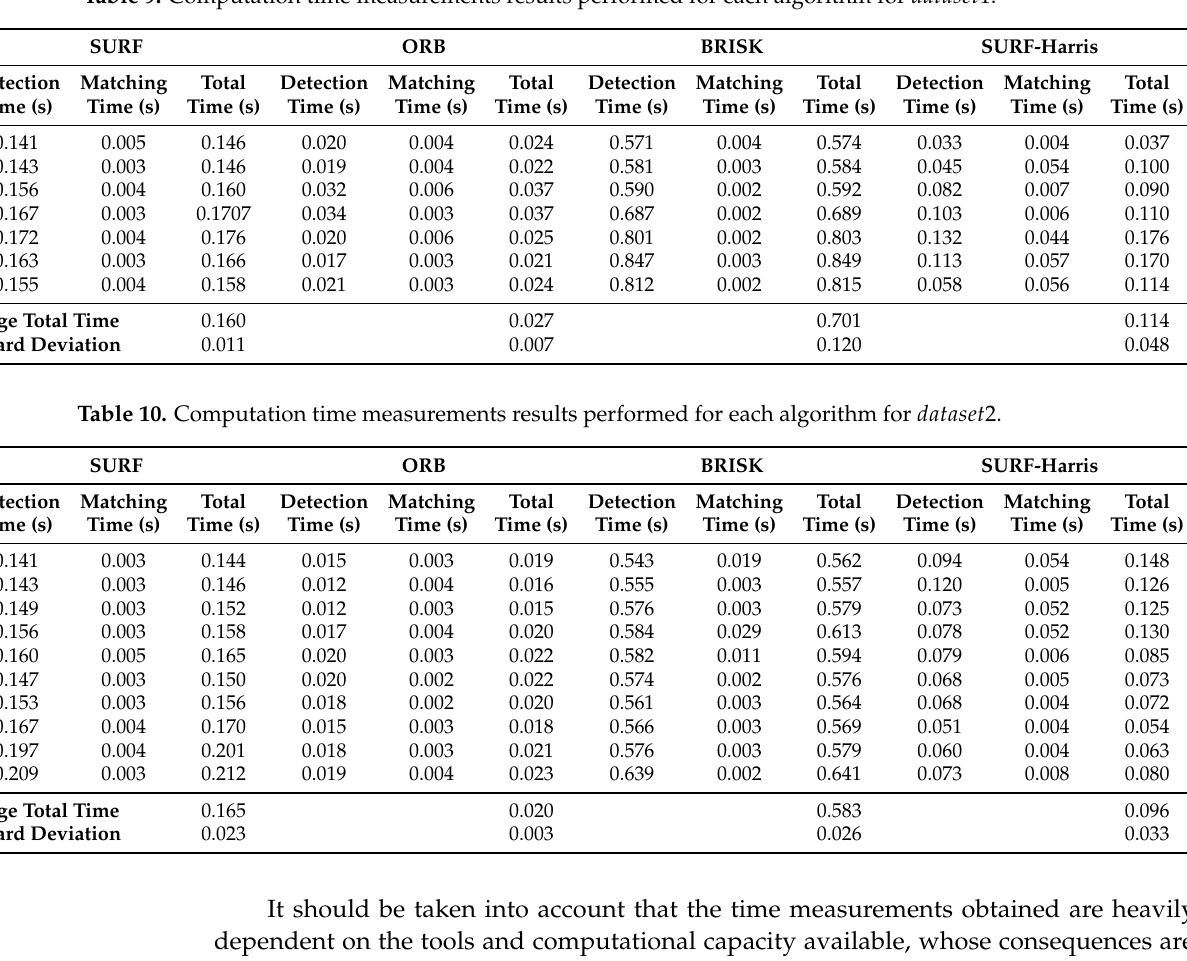
Table 9. Computation time measurements results performed for each algorithm for dataset 1.